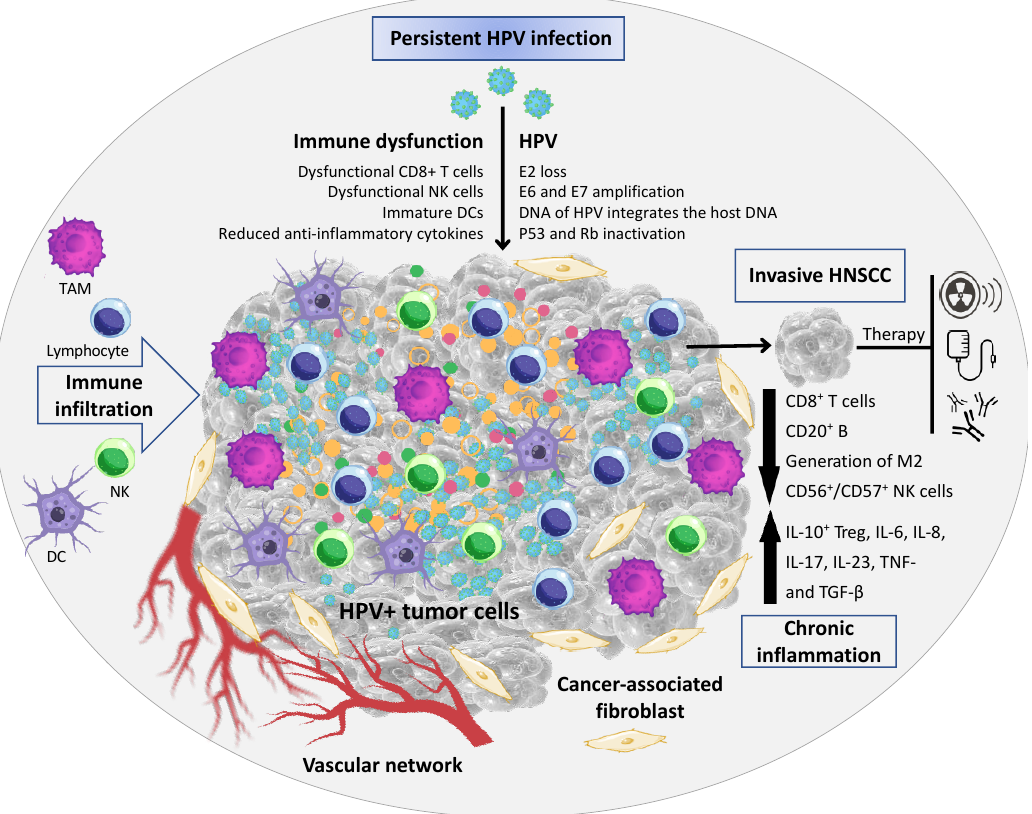
Figure 1. Tumor microenvironment (TME) associated with HPV+ HNSCC. The TME comprises malignant epithelial cells, and a heterogeneous cell population integrated in a complex extracellular matrix (ECM) 16. The main cellular components of the TME are tumor-infiltrating lymphocytes (a.k.a.: TILs; or B and T lymphocytes), tumor-associated macrophages (TAMs), natural killer cells (NKs), tumor-associated neutrophils (TANs), dendritic cells (DCs), and cancer-associated fibroblasts (CAFs). In HPV+ HNSCC the virus has a key role in the immune dysfunction by the recruitment and activation of cytokines- and chemokines-regulating cells associated with tumor growth and dissemination (Image created using Canva Pro Software at https://www.canva.com/pro/). The better prognosis of HPV+ HNSCC when compared to HPV- HNSCC has been associated with the higher number of TILs [20 – 22]. The TIL population can be classified into two major subsets: CD4+ and CD8+ T lymphocytes (Figure 2). Furthermore, the effec- tor CD4+ T lymphocytes are subdivided into two groups with distinctive characteristics: regulatory T (Treg) and helper T (Th) cells [23]. In HNSCC, the CD8+ T lymphocyte infil- tration has anti-tumoral activity and its presence is related to a favorable outcome [24]. In HPV+ HNSCC, the tumor antigen tolerance has been attributed to the presence of abun- dant levels of activated Treg lymphocytes within the TME [25 – 27]. However, effector T cells can polarize into exhausted T cells leading to cancer immune evasion [28]. T-cell ex- haustion is a hyporesponsive state of T cells characterized by increased inhibitory recep- tors (such as: cytotoxic T lymphocyte antigen-4 (CTLA-4), programmed cell death protein 1 (PD-1), the T-cell immunoglobulin domain and mucin domain protein 3 (TIM-3), the lymphocyte activation gene 3 protein (LAG-3), the band T lymphocyte attenuator (BTLA), the T-cell immunoglobulin and immunoreceptor tyrosine-based inhibitory motif domain (TIGIT)), as well as the decreased effector cytokines (such as: interleukin-2 (IL-2), tumor necrosis factor- α (TNF - α), interferon - γ (IFN - γ), granzyme B (GzmB)) , which impair the cytotoxicity leading to an inability to eliminate cancer cells [27,29 – 34]. Therefore, revers- ing the T-cell exhaustion status might represent a potential strategy to treat cancer. It is known that the secretion of immunesuppressive cytokines (such as the transforming